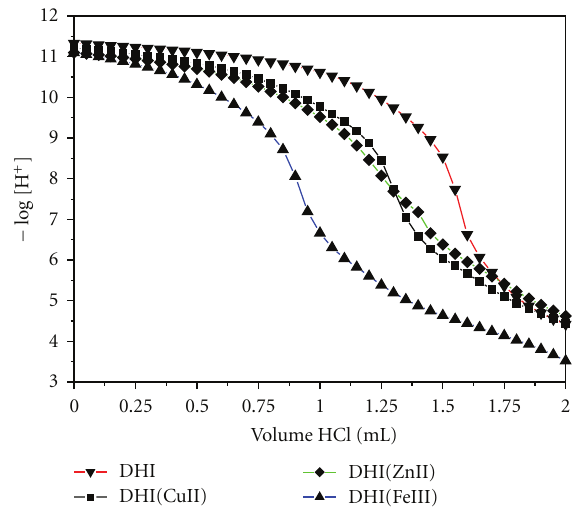
Figure 3: The titration curves of DHI melanin in the absence and presence of